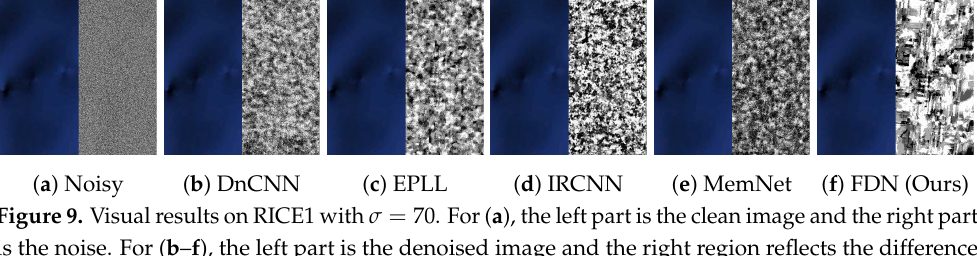
Figure 9. Visual results on RICE1 with σ = 70. For ( a ), the left part is the clean image and the right part is the noise. For ( b – f ), the left part is the denoised image and the right region reflects the difference between the denoised and GT images. Whiter pixels represent better denoising performance. The denoised image restored by FDN is closer to the ground truth.